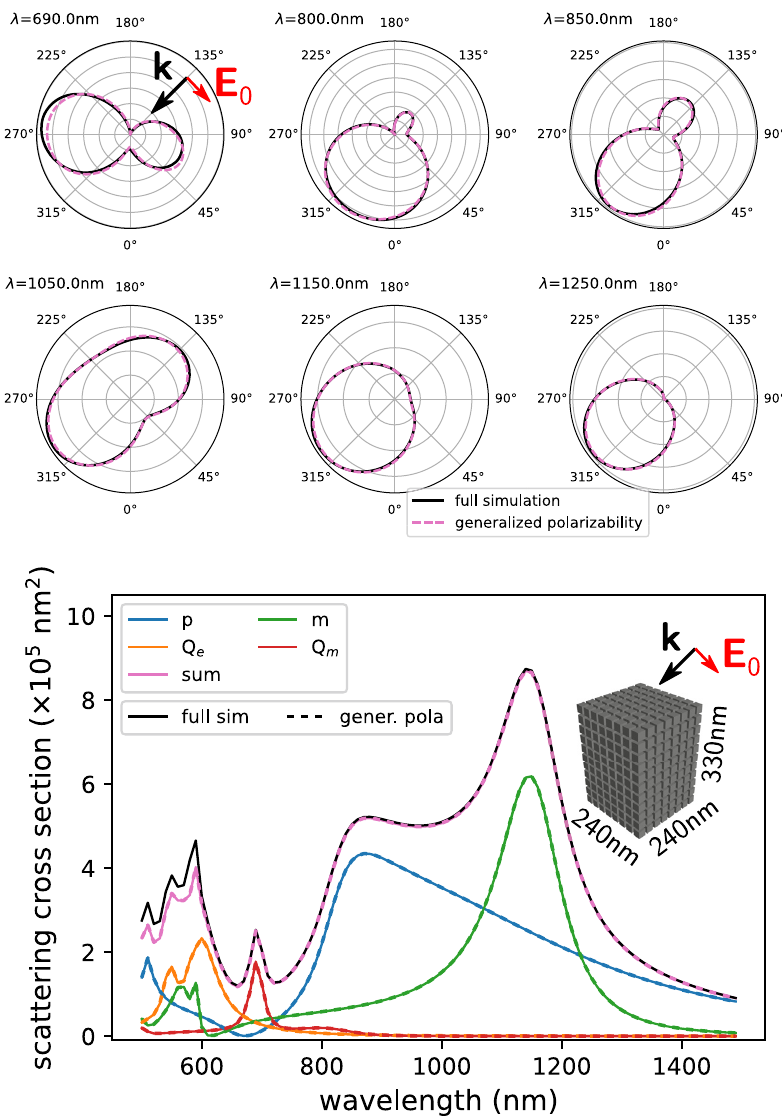
Figure 3: Comparison of far-field scattering simulations and analogous calculations with the generalized polarizability tensors. The considered nano-object is a nano-cuboid of dimensions 240 × 240 × 330 nm 3 made of a lossless material ( n = 3.5), placed in air = 1).Illuminationisa p polarized,oblique ( n env plane wave at an incident angle of 135 ◦ . Top: radiation patterns in the scattering plane for selected wavelengths. Solid black lines correspond to full field simulations, dashed purple lines to multipoles via the generalized polarizability.Bottom:totalfar-fieldscattering cross section (black line) and its multipole decomposition from full simulations (solid lines) as well as obtained via the generalized polarizabilities (dashed lines of same